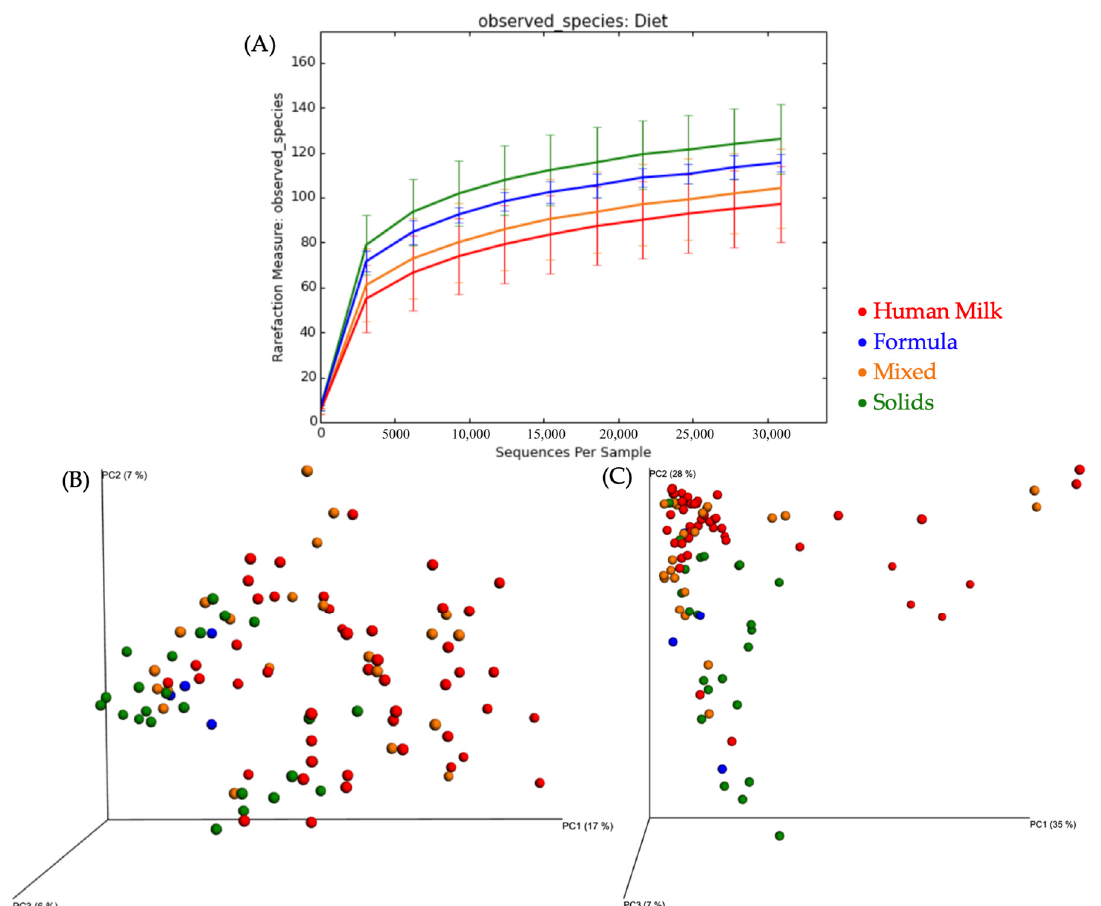
Figure 2. ( A ) Rarefaction curves showing bacterial species richness based on feeding method. Mean number of bacterial operational taxonomic units (OTU) per subject for feeding method. ( B ) Unweighted PCoA plot of identified bacterial OTUs, shows plot for feeding method. ( C ) Weighted PCoA plot of identified bacterial OTUs, shows plot for feeding method.